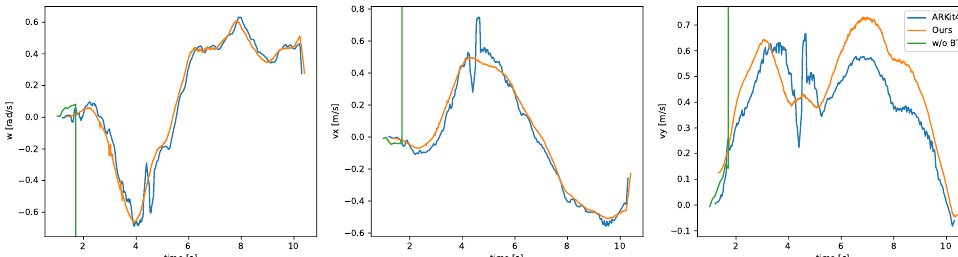
Figure 11. Results of the motion estimation experiment on a carpeted surface. Blue: ARKit4. Orange: proposed method with the bird’s-eye view transformation. Green: entropy minimization method without the bird’s-eye view transformation.